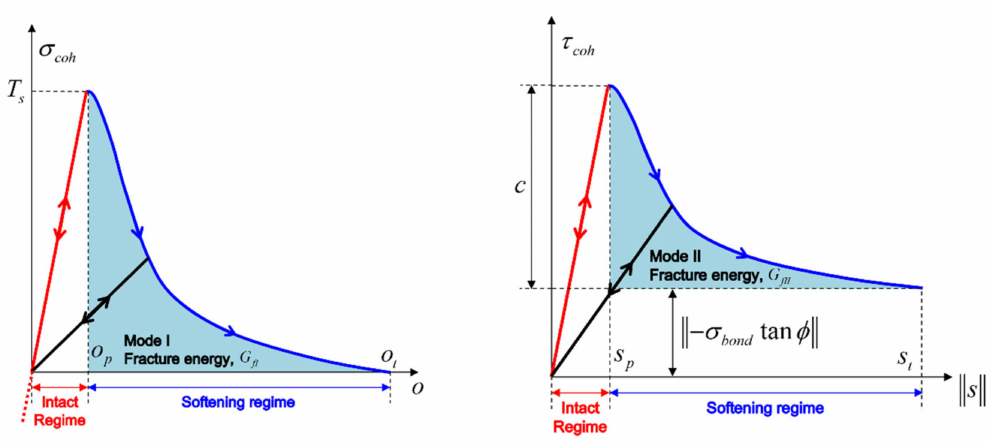
Figure 2. Tensile ( left ) and shear ( right ) softening curves in the